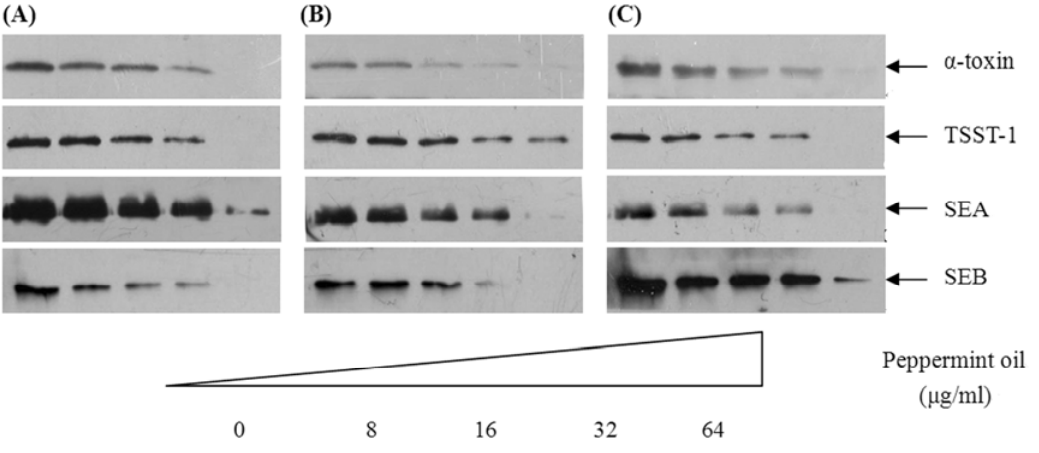
Figure 2. Western blot analysis of α -toxin, TSST-1, SEA and SEB production. S. aureus strains ATCC 29213 (A), MRSA 2985 (B) and MRSA 3701 (C) were cultured to the